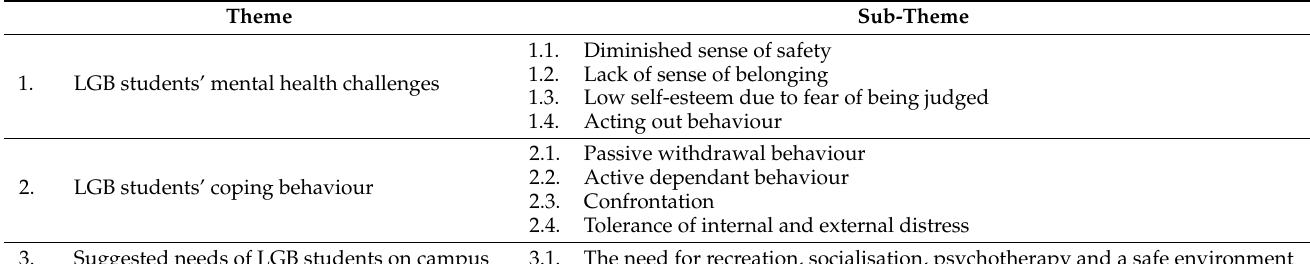
Table 2. Theme and